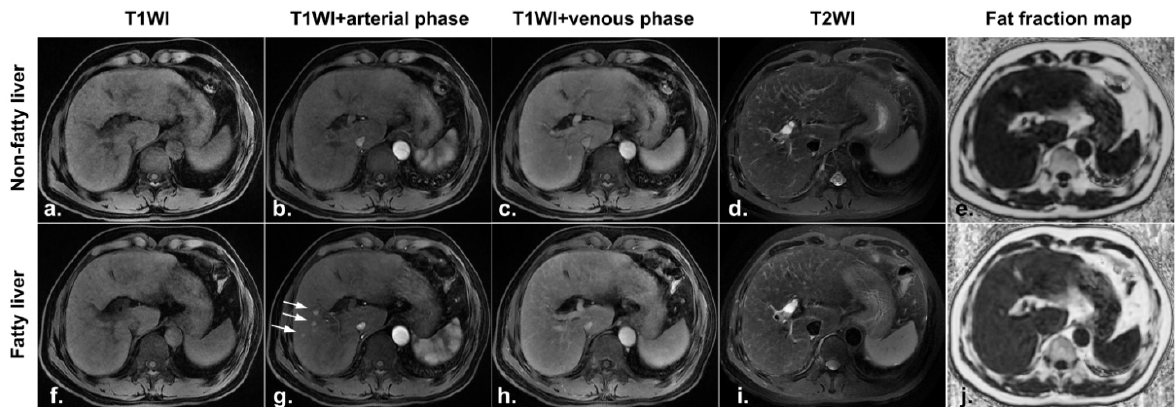
Figure 4. A 51-year-old male patient underwent surgical resection of a small hepatocellular carcinoma. MRI images one month after radiofrequency ablation ( a – e ): no lesions were found on both T1W ( a , f ) and T2W ( d , i ); the fat fraction map showing no fat deposition in the liver ( e ); contrast-enhanced images showing no abnormal perfusion foci ( b , c ). MRI images four months after radiofrequency ablation ( f – j ): a fat fraction map showing new fat deposition in the liver ( j ); a contrast-enhanced image in the arterial phase showing hyperperfused foci(white arrows) in the liver ( g ); isointense signals in the portal venous phase ( h ).